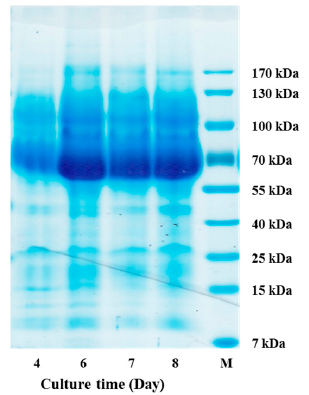
Figure 6. Confirmation of the crude enzyme using SDS-PAGE for each culture day.